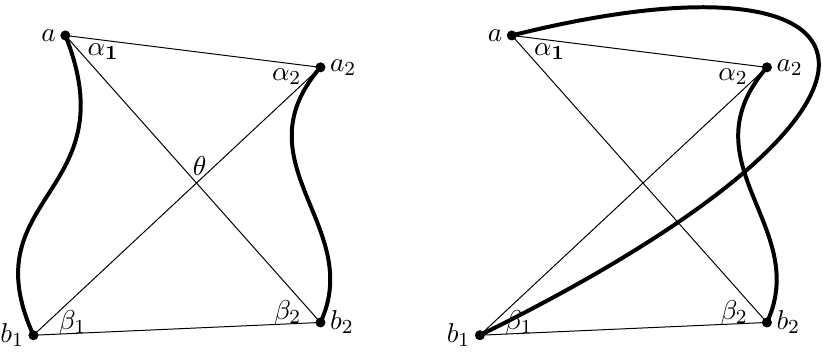
Figure 2 . Two con(cid:12)gurations of the curves C (cid:3)